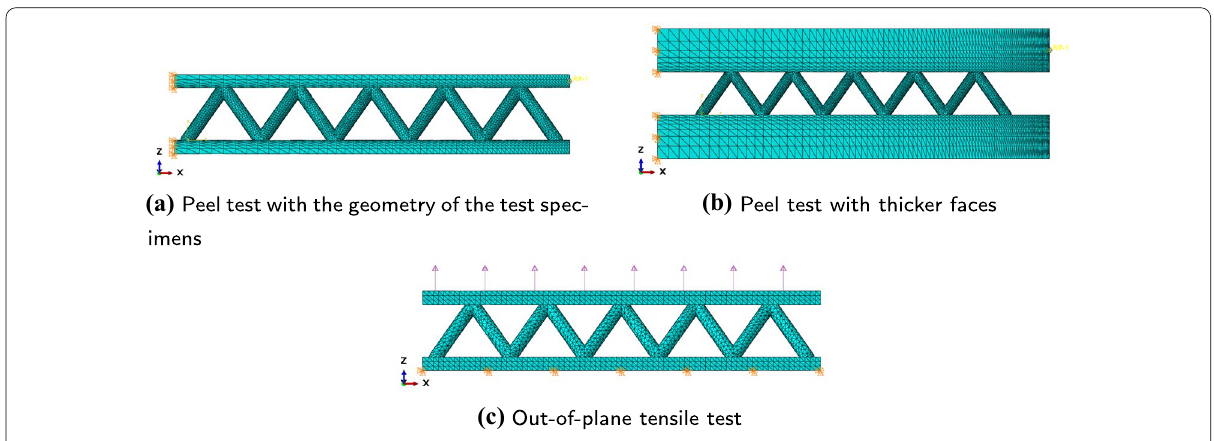
Figure 9 Finite element models for the peel and out‑of‑plane tensile